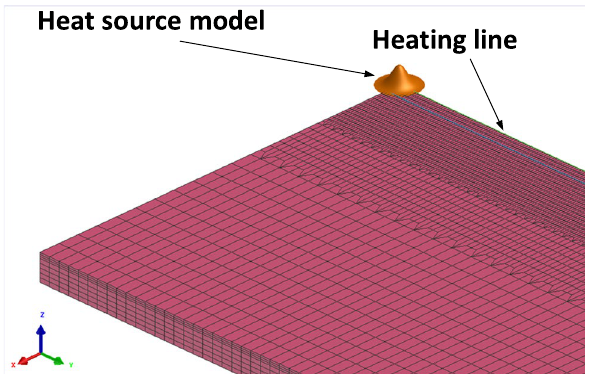
Figure 2. Heat source model.